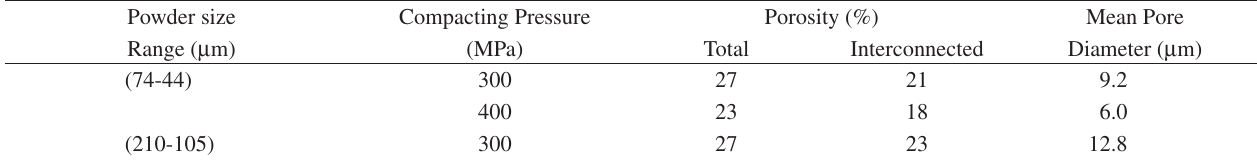
Table 1. Porosity characteristics of the filters. Powder size Compacting Pressure